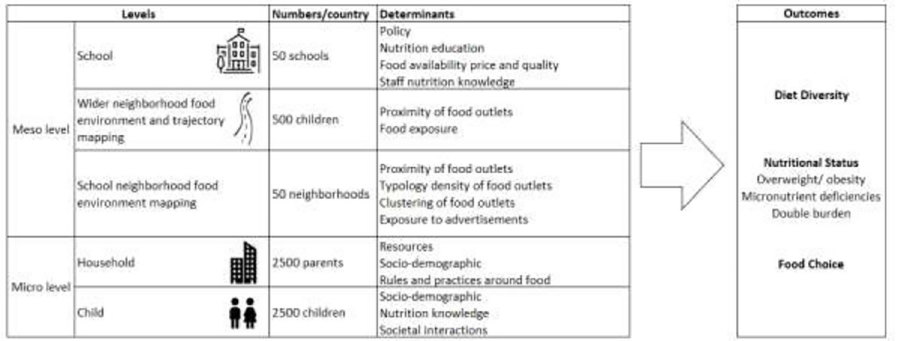
Fig 3. Meso and micro level factors that influence children’s diet diversity, nutritional status, and food choice.